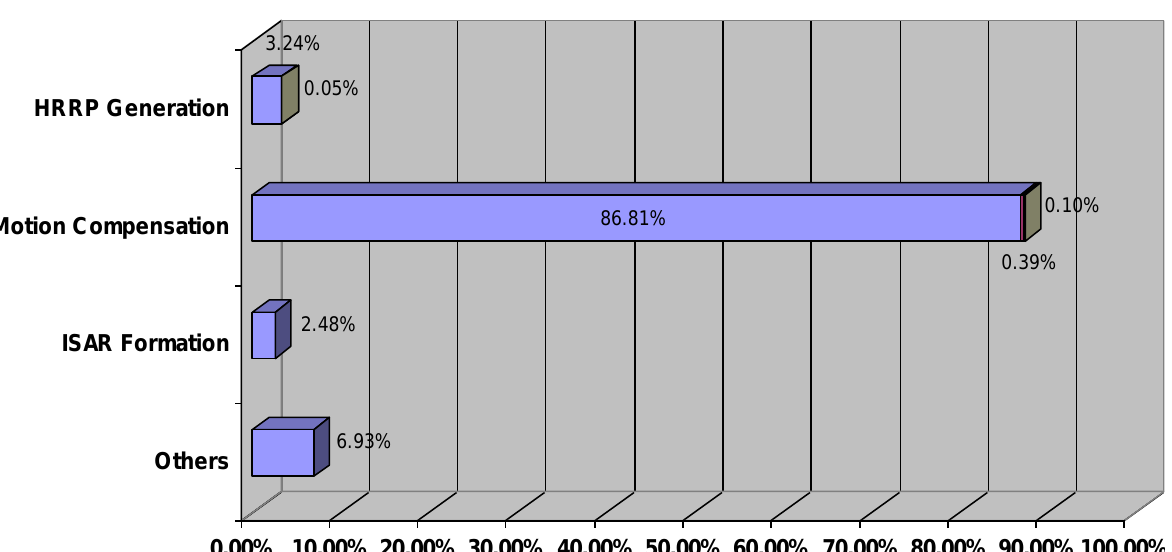
Figure 12. Time spent in the generation of an ISAR